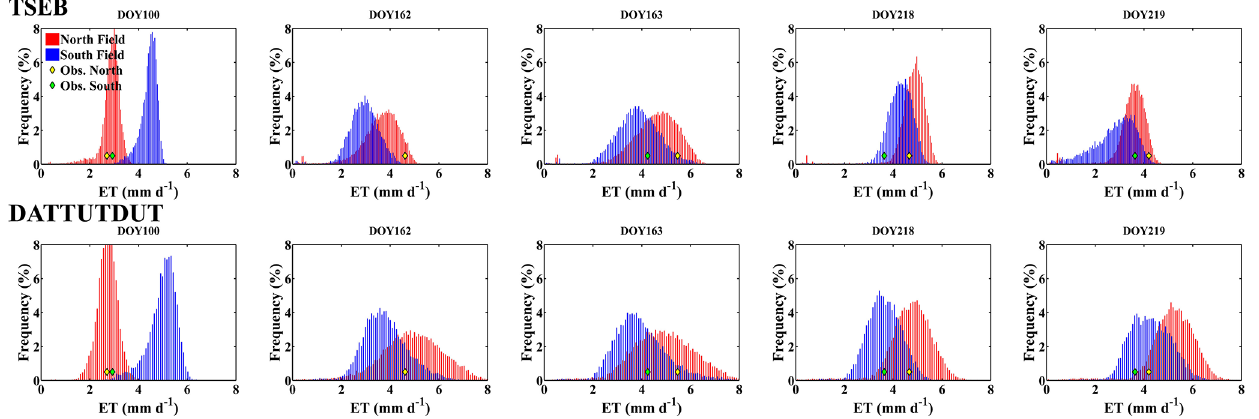
Figure 12. Histograms of output of spatially distributed daytime ET estimated from the TSEB and DATTUTDUT with the daytime ET values from the flux towers identified in the distributions by a yellow and green diamond for the northern and southern vineyards, respectively.